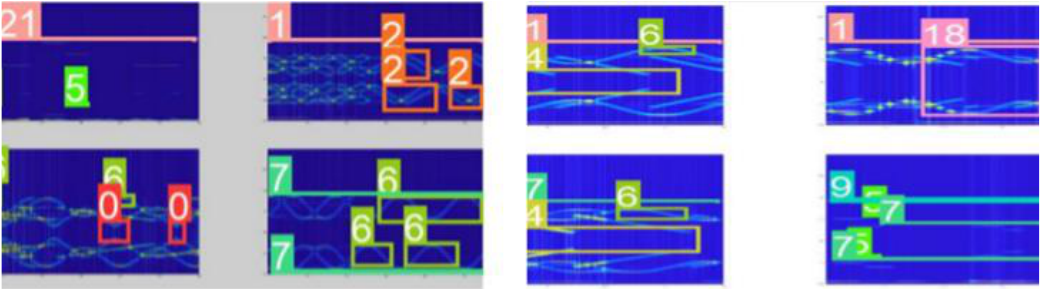
Figure 10. Data enhancement of the CWD time-frequency graph training process by input.